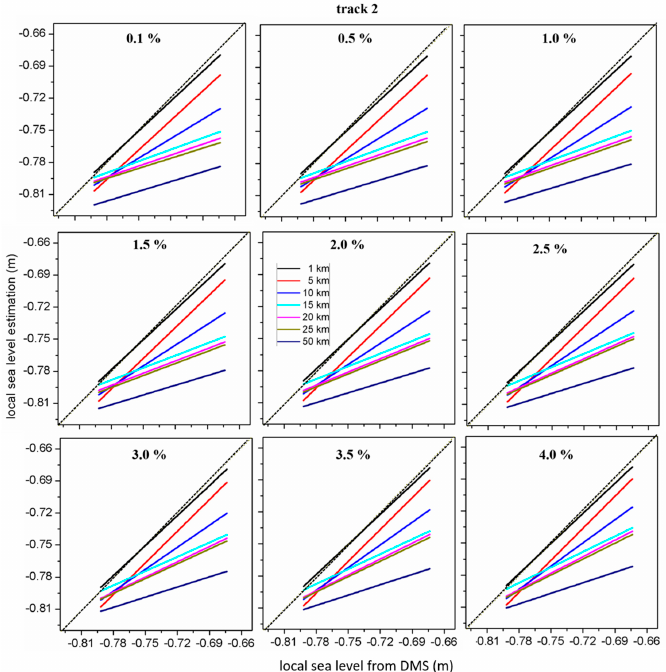
Figure 4. Linear fit lines of track 2 between retrievals from the lowest elevation method and those from the DMS method (ground truth) at 7 segment length scales: 1, 5, 10, 15, 20, 25, and 50 km, and 9 percentage scales: 0.1%, 0.5%, 1%, 1.5%, 2%, 2.5%, 3%, 3.5%, and 4%. The dashed line is the 1:1 line. All linear least square fits are statistically significant with greater than 95% confidence using an F test. Remote Sens. 2020 , 12 , x FOR PEER REVIEW